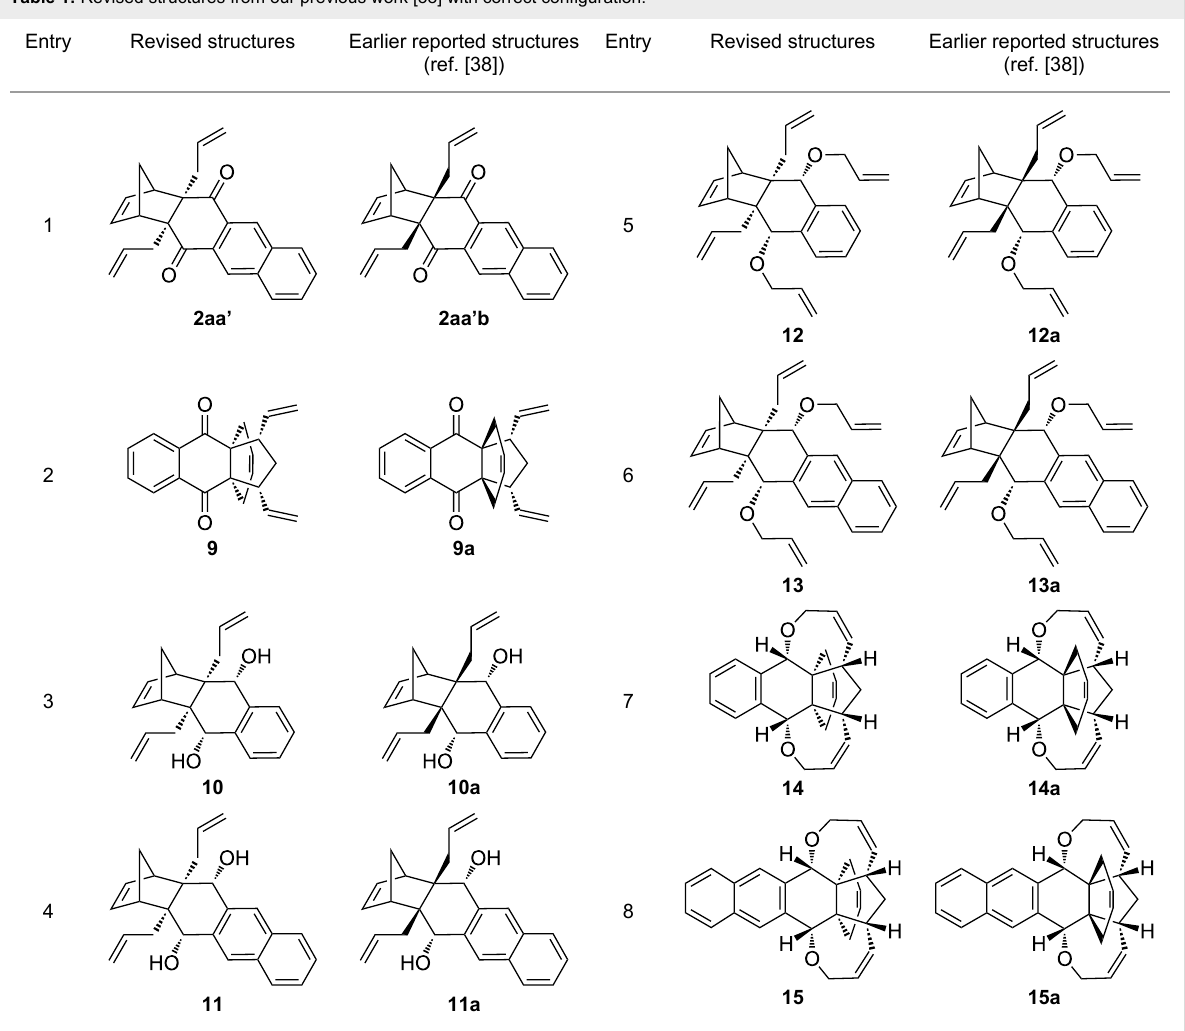
Table 1: Revised structures from our previous work [38] with correct